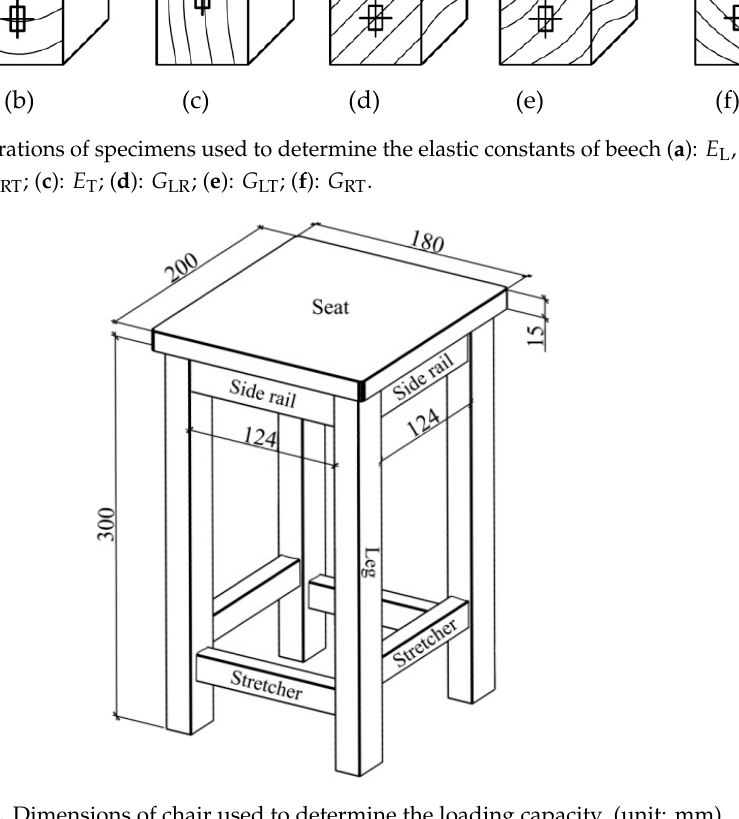
Figure 3. Dimensions of chair used to determine the loading capacity. (unit: mm).